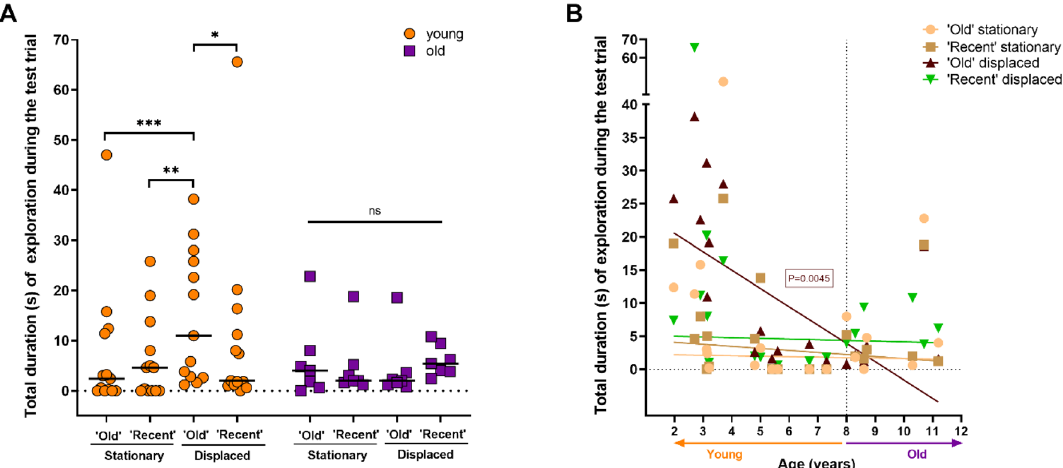
Figure 3. Exploratory behaviour during the test trial. ( A ) Total time of exploration (duration in seconds), by the different groups (young individuals (Orange filled circle); old (purple filled square)) of the different objects (‘old’ stationary, ‘recent’ stationary, ‘old’ displaced and ‘recent’ displaced) during the test trial. Individual values are shown. The horizontal black line represents the group median ( * P < 0.05 , ** P < 0.01, ***P < 0.001, ns: not significant). ( B ) Individual values for total duration (in seconds) of exploration of the different objects (‘old’ stationary, ‘recent’ stationary, ‘old’ displaced and ‘recent’ displaced) during the test trial. Straight lines represent the robust linear